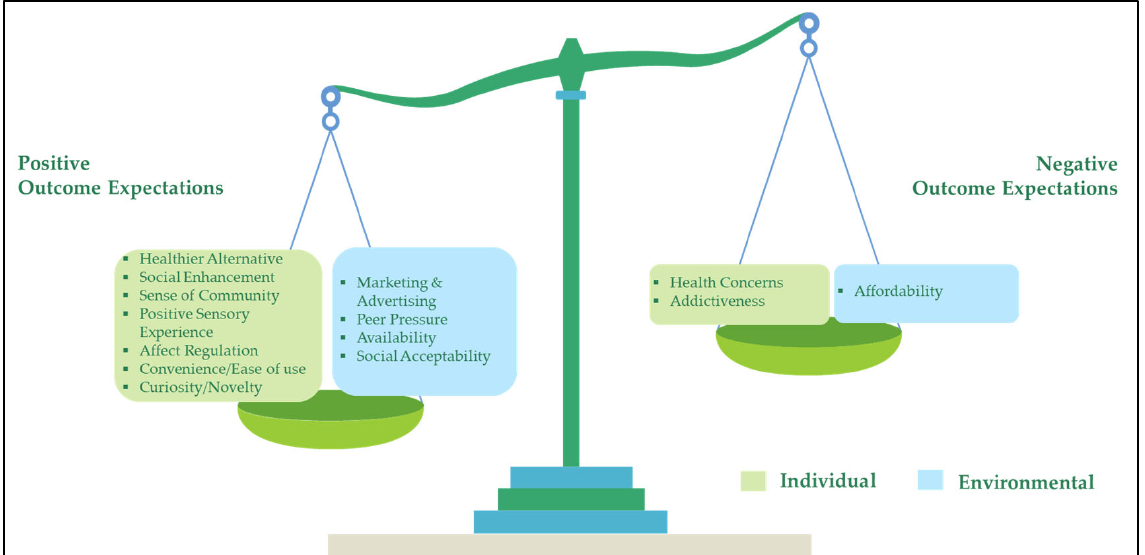
Figure 1. Participants’ positive versus negative outcome expectations at the individual and environ- mental level.